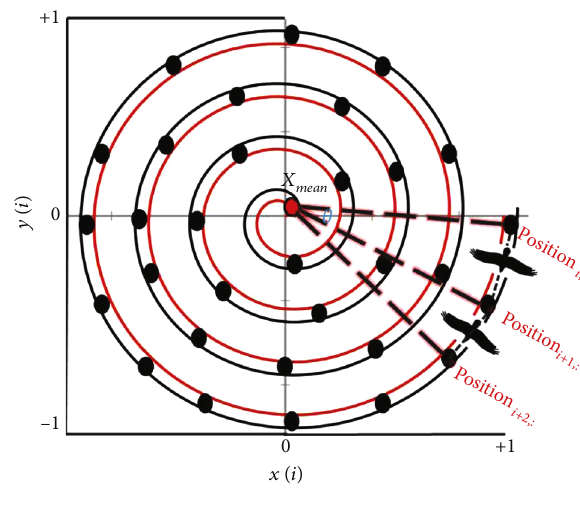
Figure 6: Spiral search [54].